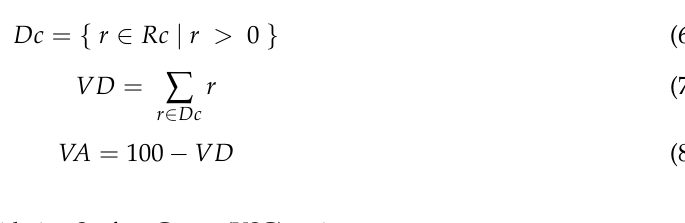
Table 1. Validation Surface Group (VSG)